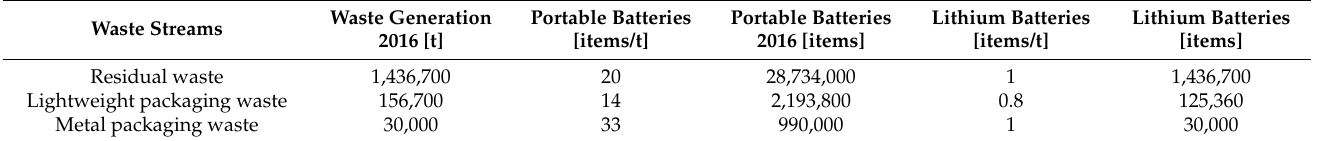
Table 1. Particle-based data for portable and lithium batteries in various municipal waste streams (data from [4]). Waste Streams